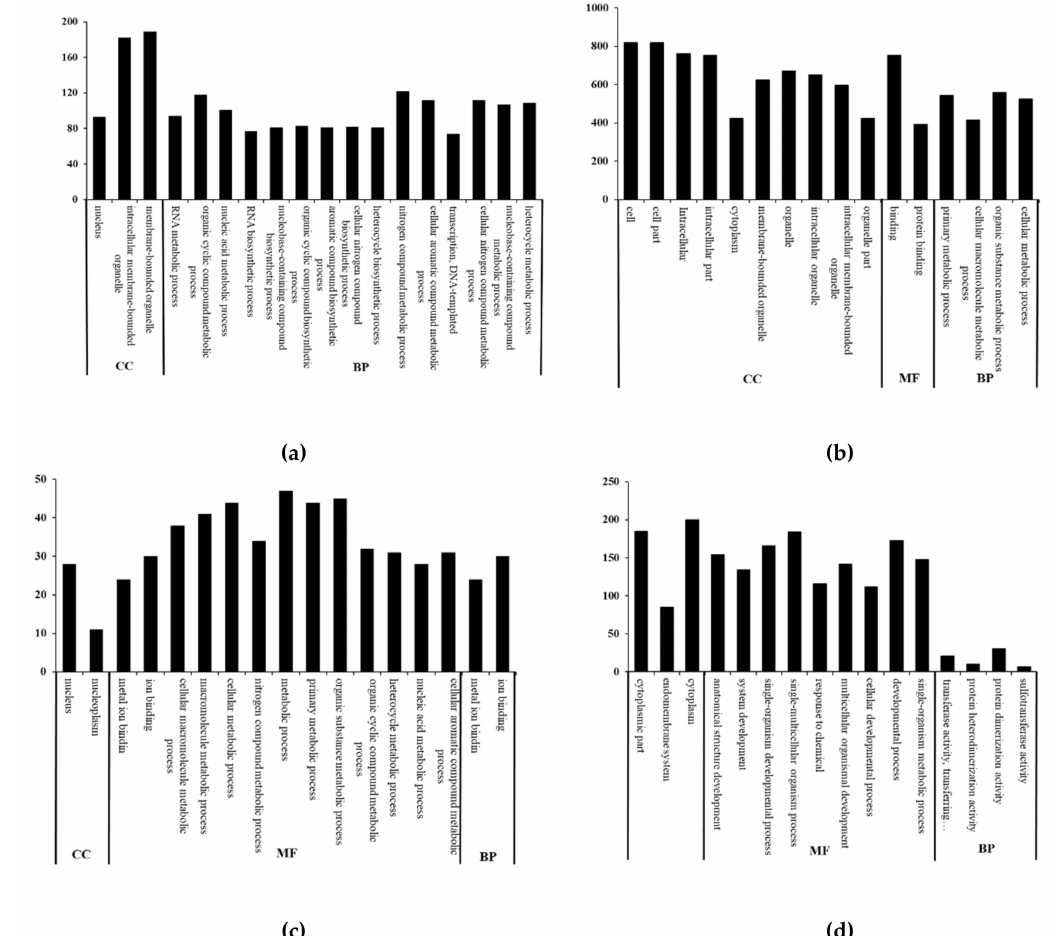
Figure 4. GO classification of significant di ff erentially expressed genes (DEGs) from colon epithelial cells exposed to BaP treatments. ( a ) Control vs BI-04; ( b ) Control vs BaP; ( c ) BaP vs BI-04 + BaP; ( d ) Control vs BI-04 + BaP. Significant DEGs which are p -value ≤ 0.05 are collected. CC represents cell component; MF means molecular function; BP indicates a biological